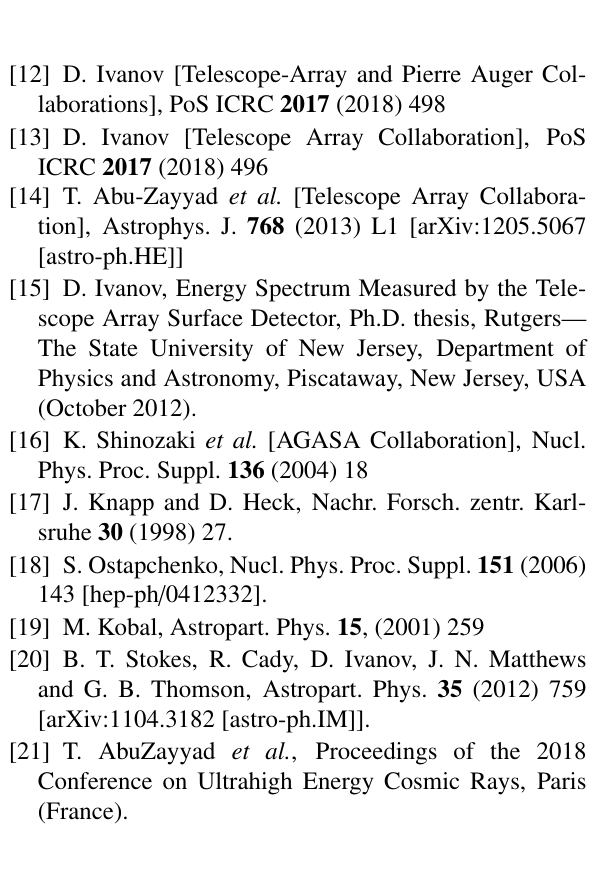
Figure 9. The TA SD energy spectra calculated using the CIC method, shown as red filled circles, and the standard TA method, shown as the open squares. The left panel compares the results for the lower declination band, − 15 . 7 ◦ < δ < 24 . 8 ◦ , and the right panel compares the results for the higher declination band, 24 . 8 ◦ < δ < 90 ◦